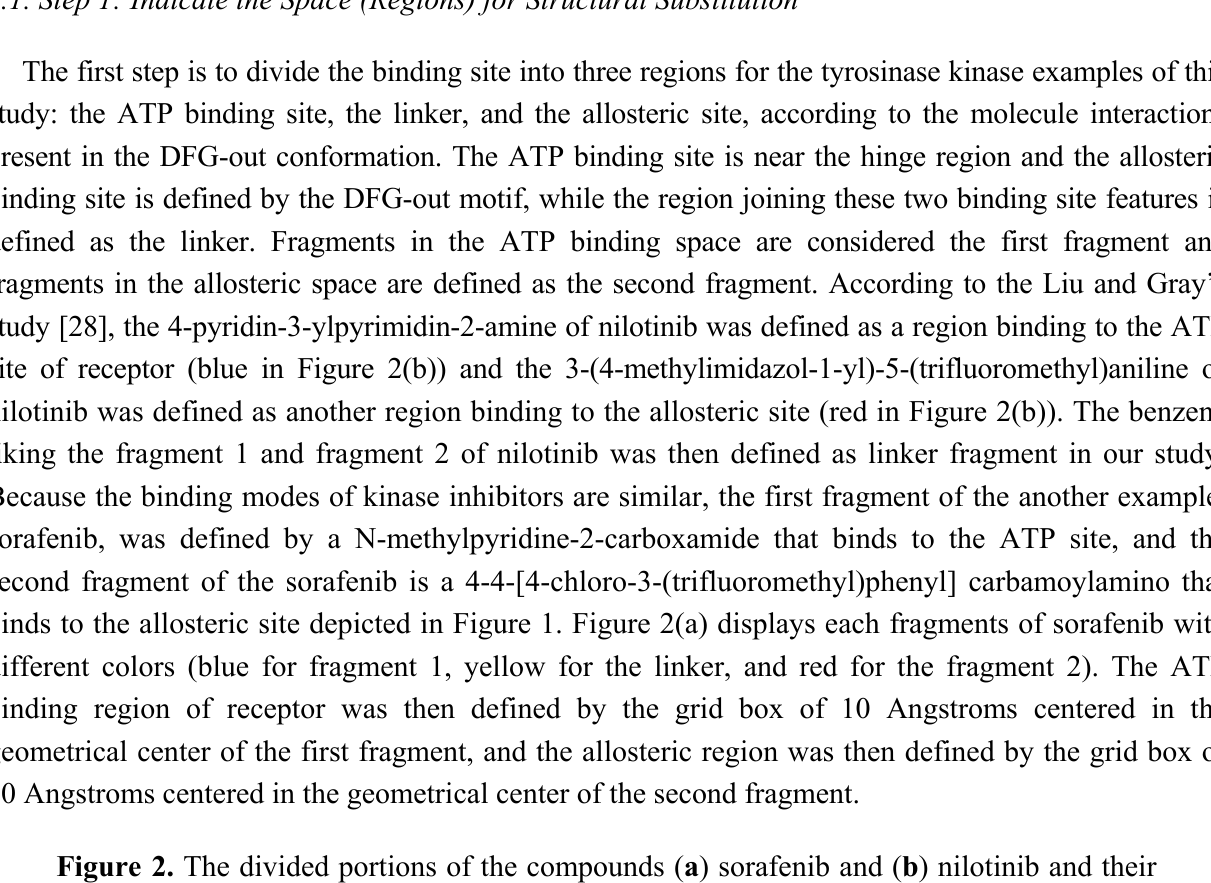
Figure 2. The divided portions of the compounds ( a ) sorafenib and ( b ) nilotinib and their binding structure with B-RAF. The fragment 1 (blue ellipsoid and sticks) in each compound was the ATP site. The fragment 2 (red ellipsoid and sticks) in each compound was the allosteric site. The linker connecting both fragments in each compound was marked as yellow ellipsoid and